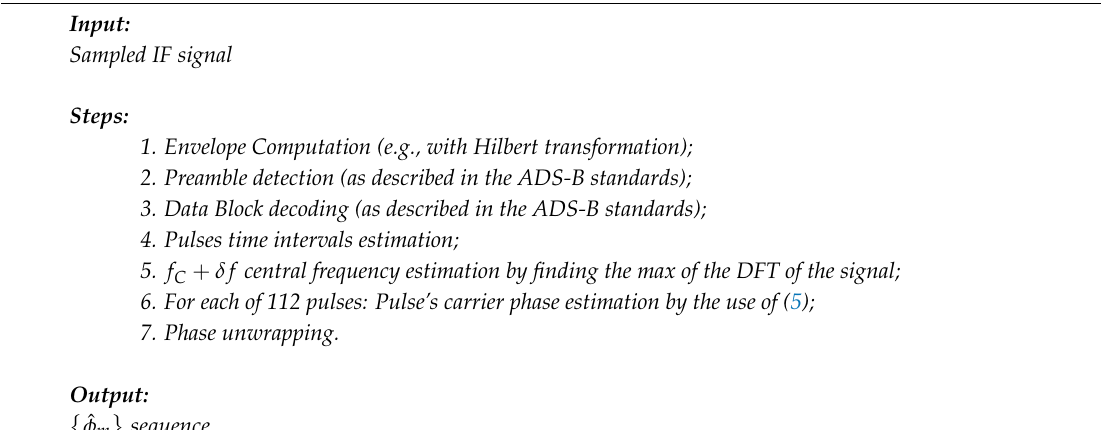
Algorithm 1: Phase pattern